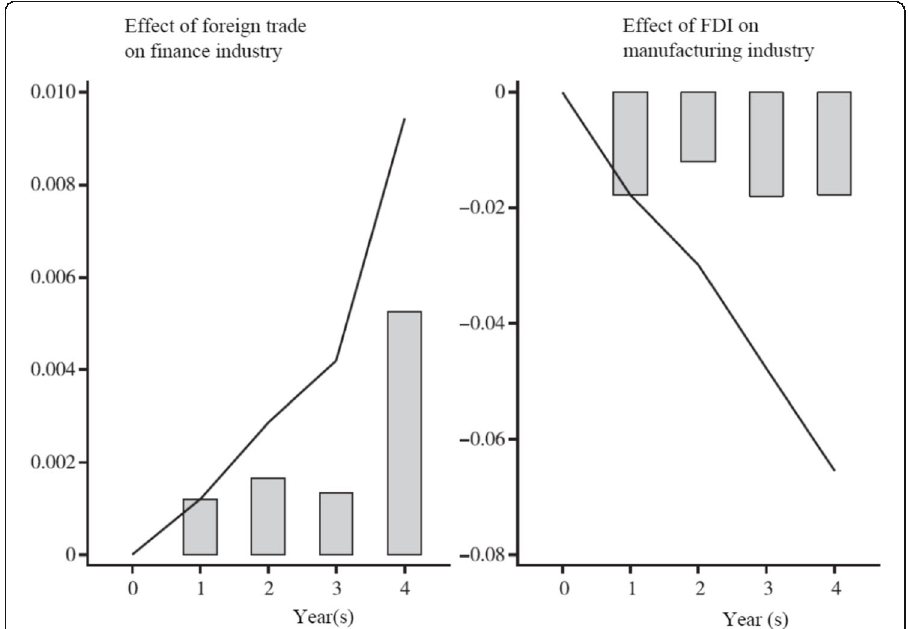
Fig. 3 Lag distribution of the effect of foreign trade and